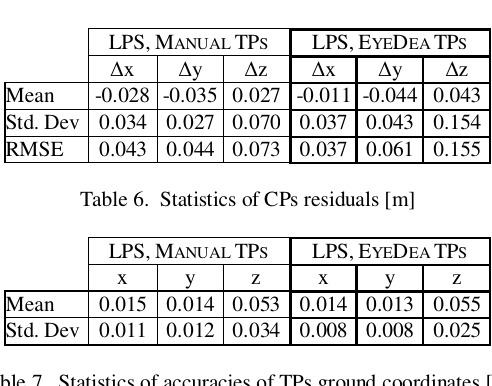
Table 10. Statistics of differences in EO parameters (lengths in meters, angles in